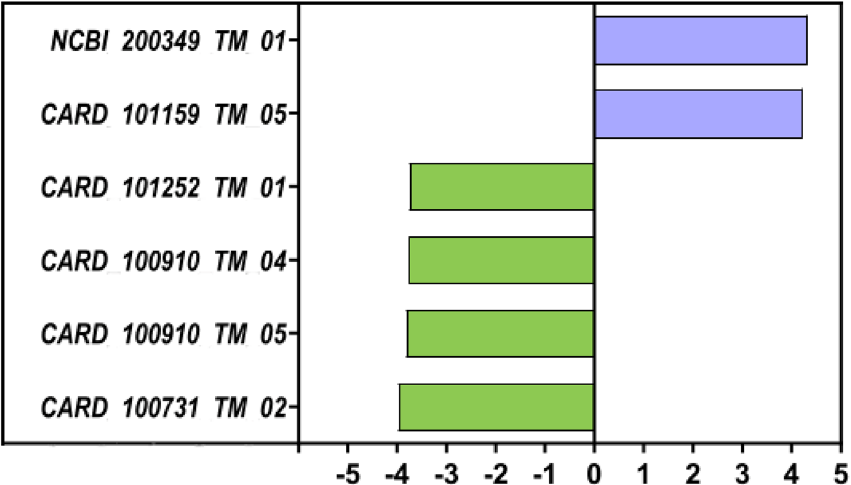
Figure 7. LefSe analysis of the resistome profile indicated 6 AMR conferring genes as altered by phytogen, two associated with phytogen (purple) and four with control birds